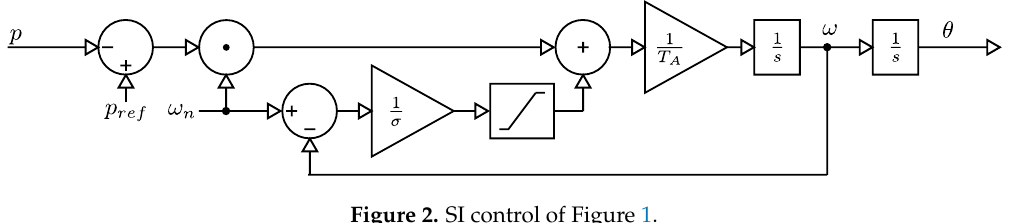
Figure 2. SI control of Figure